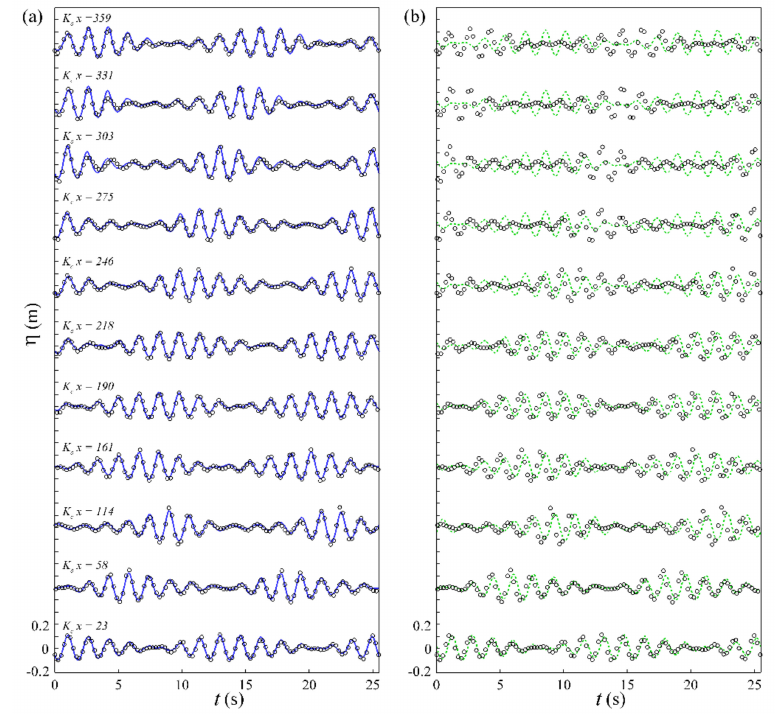
Figure 11. Same as Figure 9 , except for non-linear bi-chromatic waves (case B11): ( a ) FNHS results and ( b ) QNHS results.